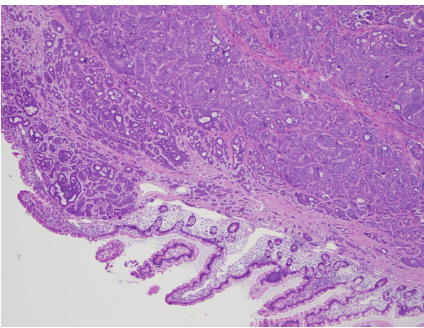
Figure 2: High power view showing cytologically bland cells with round monomorphic nuclei and granular chromatin.